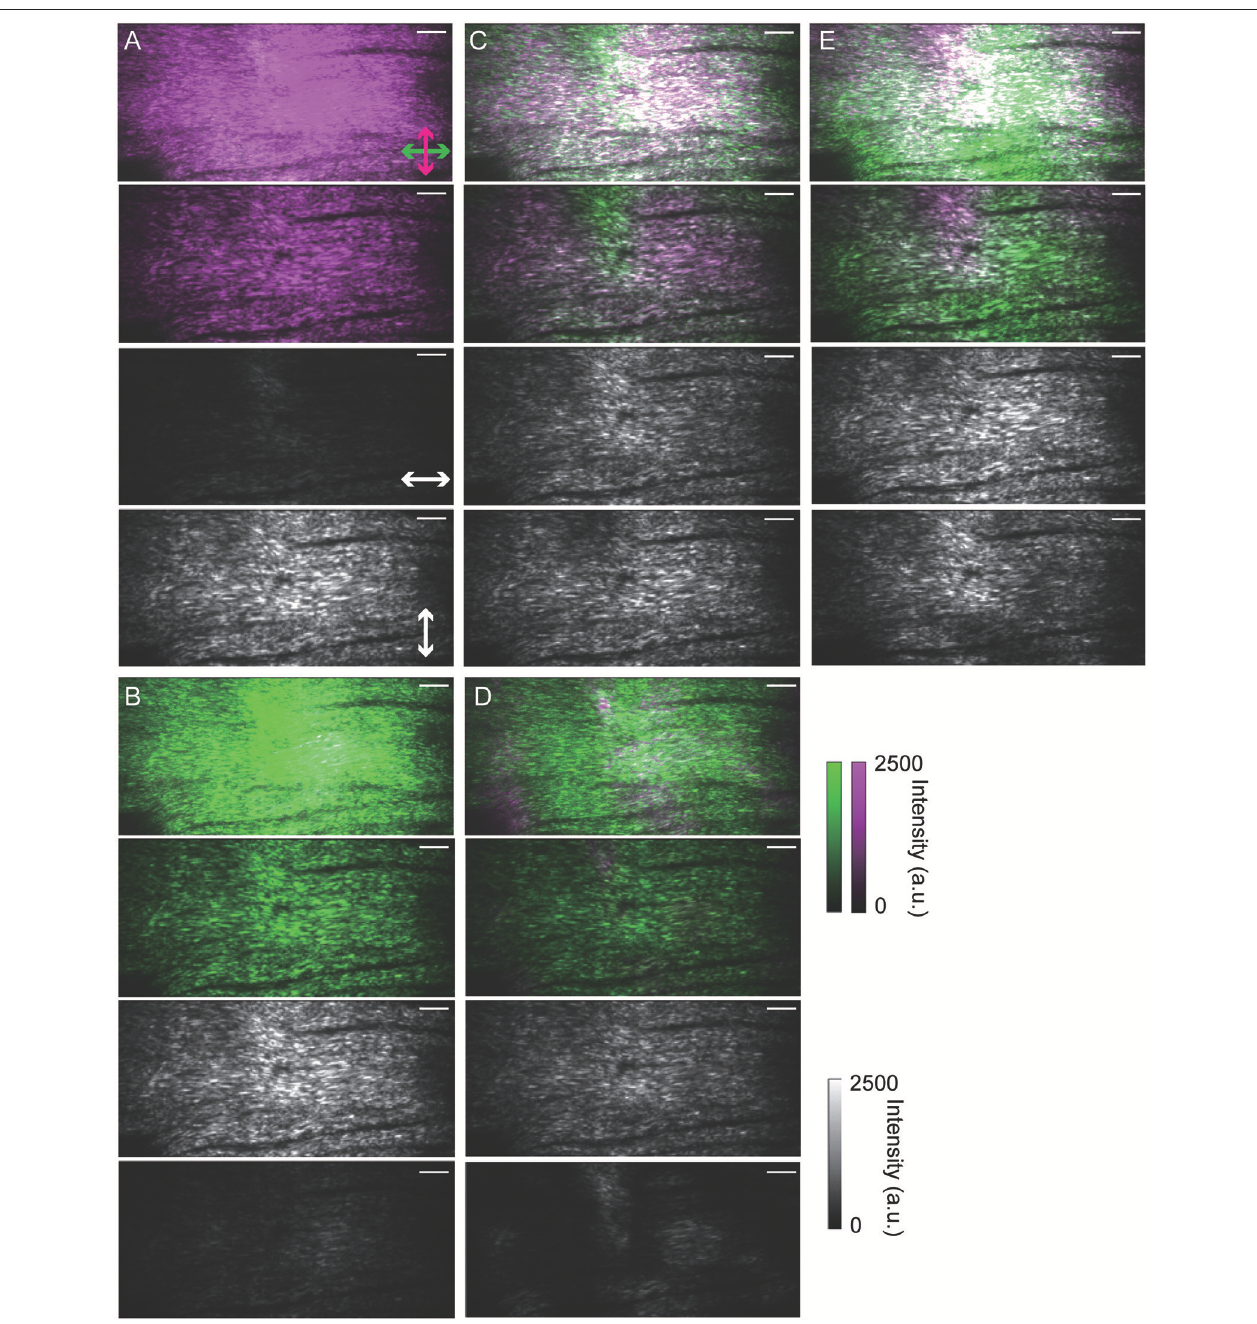
FIGURE 5 | Polarization-resolved SHG images of collagen fibers in a fixed mouse skeletal muscle sample. (A) Under irradiation of circularly polarized light. (B–E) Under irradiation of linearly polarized light. Images taken when lateral polarization angles were set to 0, 45, 90, and 135 ◦ from the horizontal axis of the FOV are shown in (B–E) , respectively. In (A–E) , the upper images are maximum intensity projection SHG images from Z-stacks (50 µ m thick) taken at 1.0 µ m intervals. The upper-middle, lower-middle, and lower images are merged, horizontal, and vertical SHG images taken 24 µ m from the specimen surface, respectively. In each sectioned image, the exposure time was 300ms, the pixel size was 230nm × 230nm, and the FOV size was 118 µ m × 56 µ m (512 pixels × 242 pixels). Scale bars indicate 10 µ m length. with a sufficiently strong signal in 18 ms (56 fps). Figures 6A–O a linearly polarized laser light beam with a 45 ◦ angle from the shows the time series of the captured polarization-resolved SHG horizontal axis of the FOV. As Figure 6 shows, we successfully images during one cardiac beat of a living mouse. Although the captured polarization-resolved SHG images of a fascia tissue